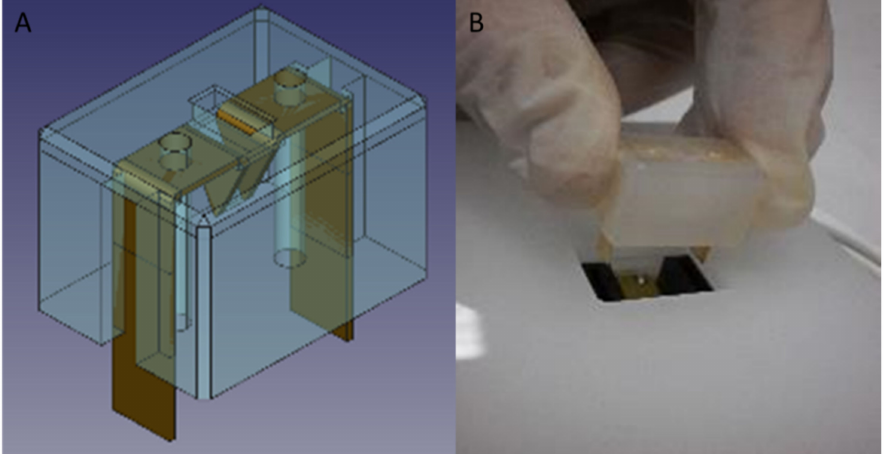
Figure 5. Moulded cuvette rendering ( A ) and final product ( B